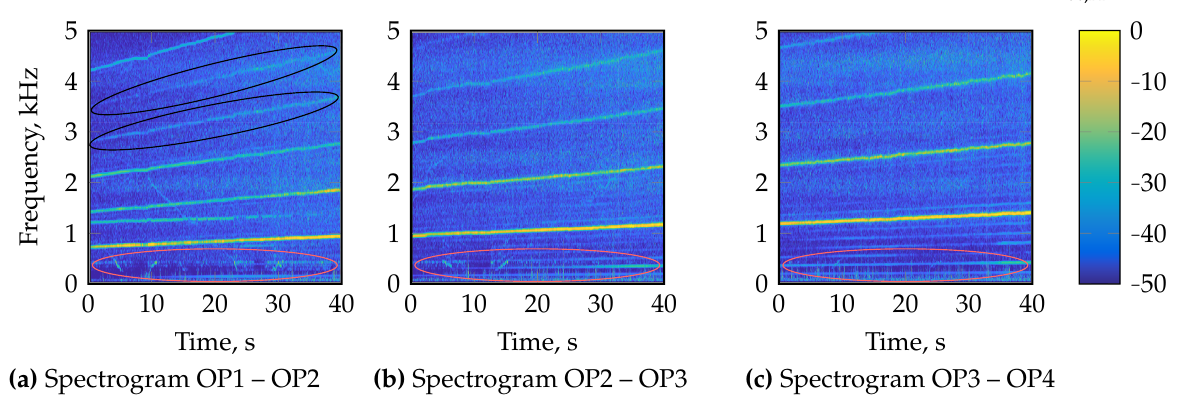
Figure 13. Spectrograms in the operating range of the modified EDF unit. Figure 13. LW,A of the modified EDF unit between neighboring operating points relative to the highest sound power level in the respective measurement range. The black and red circle mark the detailed characteristics in the spectrograms. Finally, the reported subharmonic hump between 350 Hz and 450 Hz (marked in red) visible in Figure 8 vanished with the absorber treatment [5]. The comparison with Figure 8 reveals that the third and fourth harmonic of the BPF are